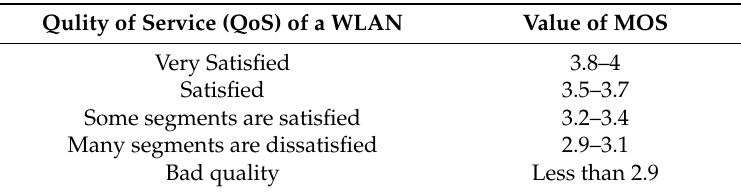
Table 1. Different quality levels of a wireless local area network (WLAN) to the different number of Mean Opinion Score